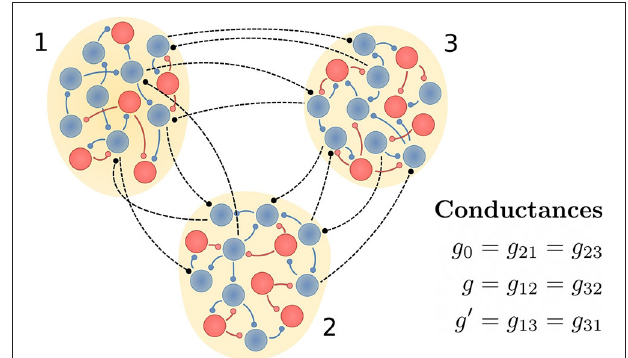
FIGURE 1 | Schematic representation of the circuit. Neural populations 1 and 3 would represent cortical areas and the population 2 the thalamus. Excitatory and inhibitory neurons (as well as their synaptic projections) are shown in blue and red, respectively. Inter-population connections are only excitatory and, depending on the case of interest, their synaptic weights are modified. If the connections between populations 1 and 3 are absent, then we call it a V-motif circuit. Otherwise, the circuit is a circular motif